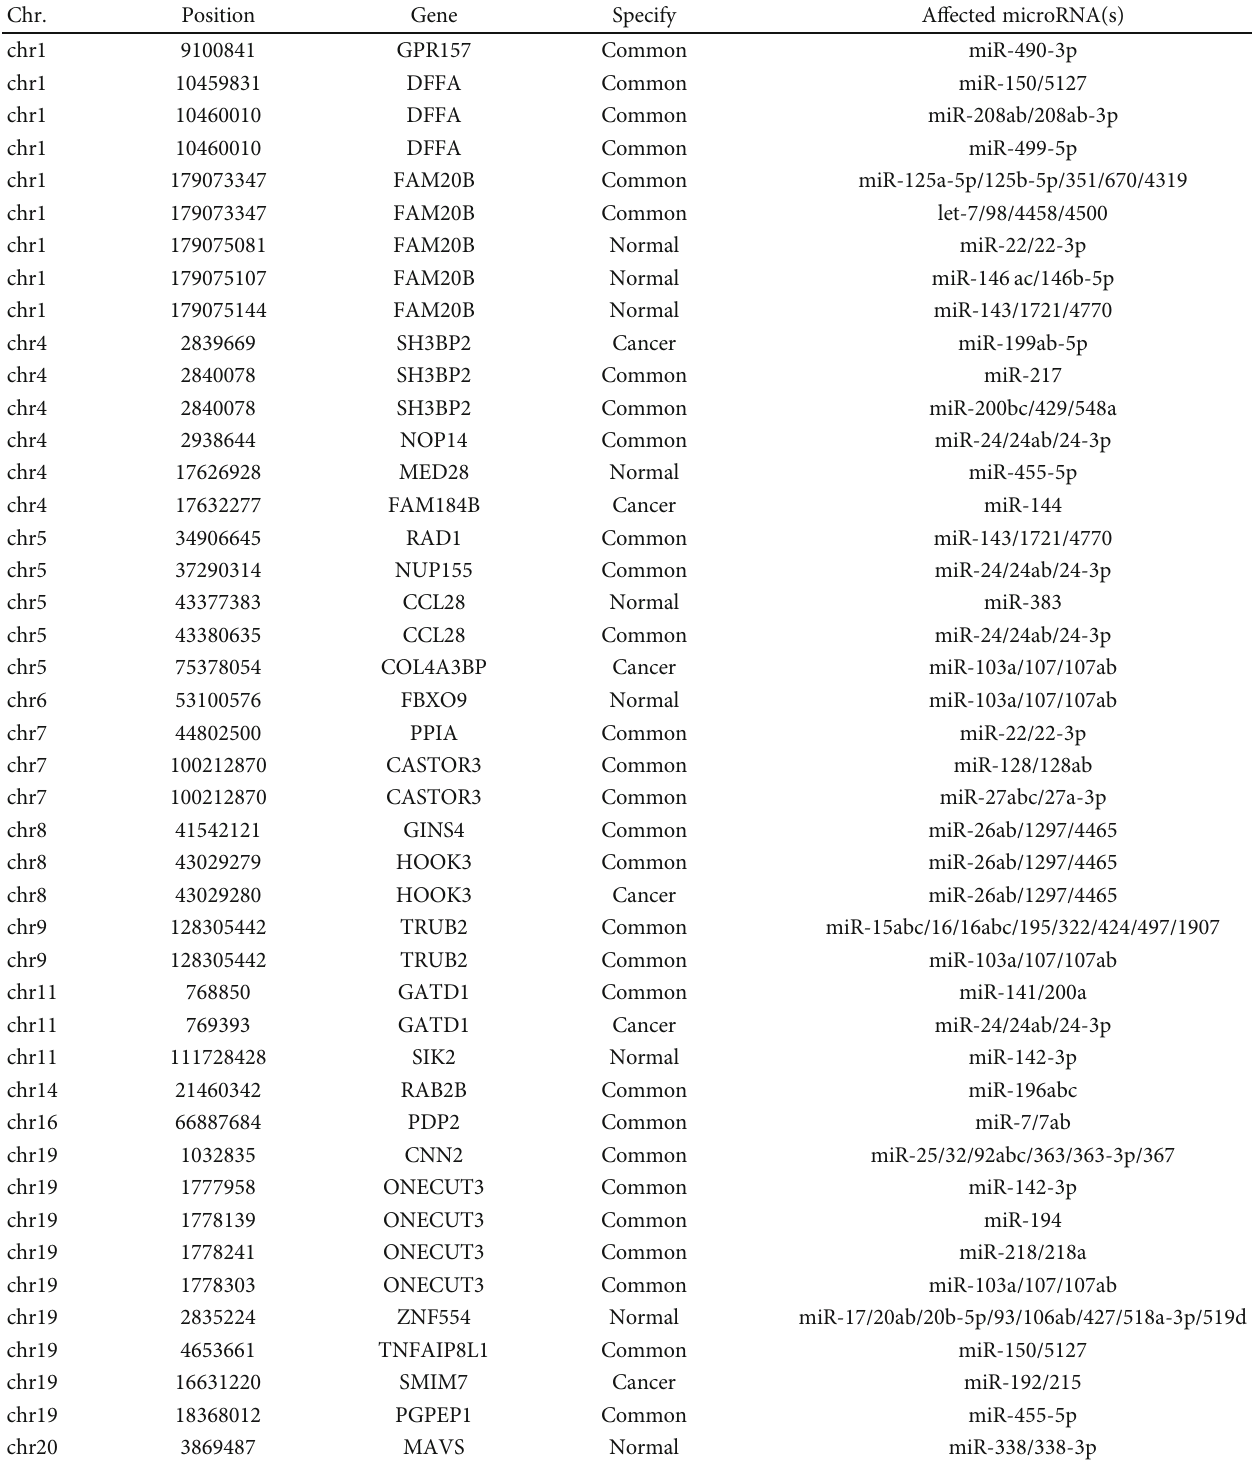
Table 4: List of editing sites that a ff ect microRNA target recognition.